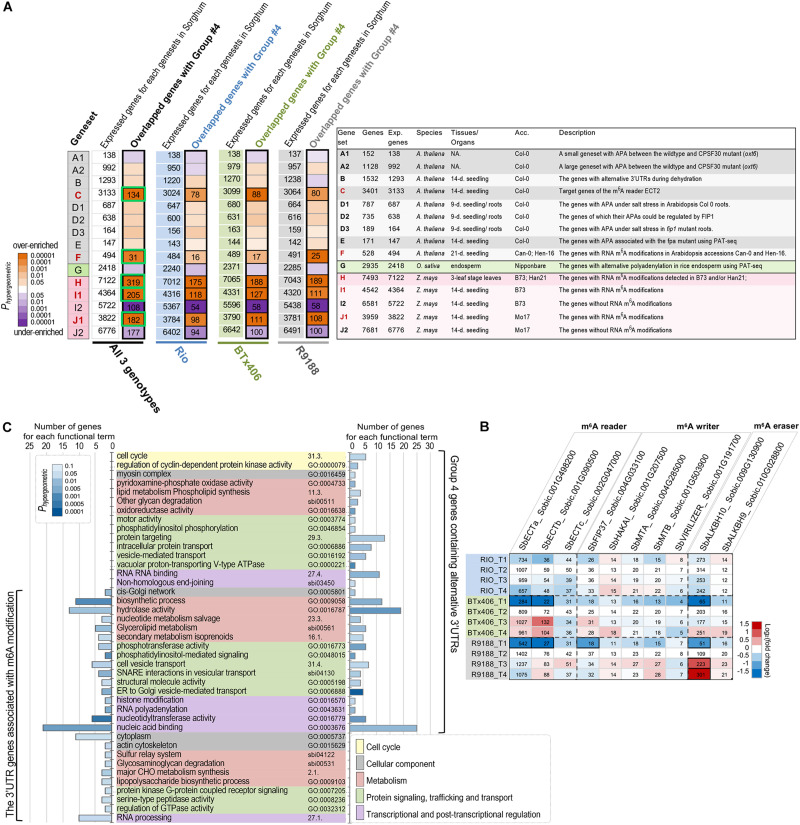
The alternative 3′UTR genes in sorghum are associated with m6A modification. (A) Significant overlapping between the high-confidence alternative 3′UTR genes in sorghum and the APA- or m6A- associated genesets (P < 0.01, hypergeometric test). The significant overlaps between genesets are labeled in black boxes, and the number of overlapping genes is shown. Green box highlights group 4 alternative 3′UTR genes potentially associated with m6A modifications, which is used for functional enrichment analysis (C). The right panel is a summary list of the published genesets of alternative polyadenylation, alternative 3′UTR, or RNA m6A modifications in Arabidopsis, rice, and maize. The number of sorghum genes (column “Genes”), expressed genes in sorghum (column “Exp. Genes”) orthologous to those in Arabidopsis, rice, or maize, and the original tissues/organs and accessions (column “Acc.”) are given (details of these genesets are provided in Supplementary Table S2). The backgrounds of the genesets are colored according to the original species, and the m6A-associated genesets (C, H, I1, and J1) are highlighted in red. The genesets and their corresponding references are as follow: genesets A1/A2—Thomas et al., 2012; geneset B—Sun et al., 2017; geneset C—Wei et al., 2018; genesets D1/D2/D3—Téllez-Robledo et al., 2019; geneset E - Duc et al., 2013; geneset F—Luo et al., 2014; genesets G—Fu et al., 2016; geneset H—Miao et al., 2020; genesets I1/I2/J1/J2—Luo et al., 2020. NA., not available; 9-days, 9-day old; 14-days, 14-day old; 21-days, 21-day old). (B) Expression dynamics of the sorghum genes encoding m6A readers, writers, and erasers. The heatmap is shaded to reflect the magnitude of log2 fold change of gene expression relative to the T2 timepoint per each genotype. Gene expression values in reads per kilobase of exon per million mapped sequence reads are given. The differentially expressed genes per genotype are highlighted in black boxes. (C) Functional enrichment results with GO, MAPMAN, and KEGG terms show that both high-confidence alternative 3′UTR genes (group 4) and its subset m6A-associated genes cover a diverse range of function aspects. Only the significant terms (P < 0.05, hypergeometric test) with at least two hit genes per term are shown.